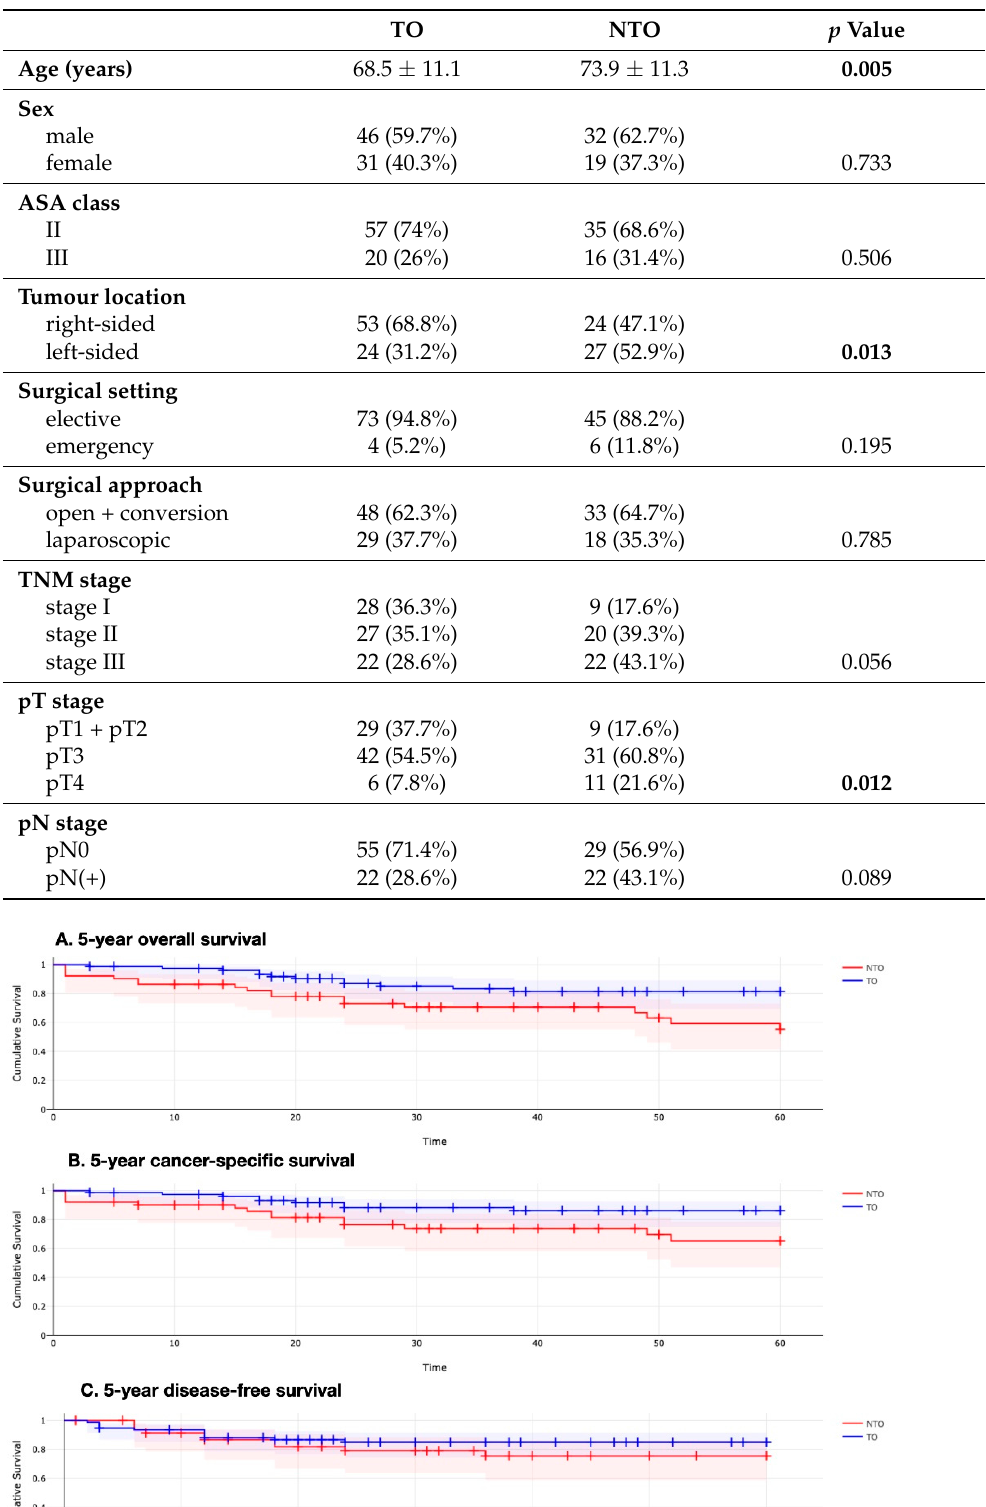
Table 3. Comparison of Textbook Outcome versus non-Textbook Outcome subgroups.